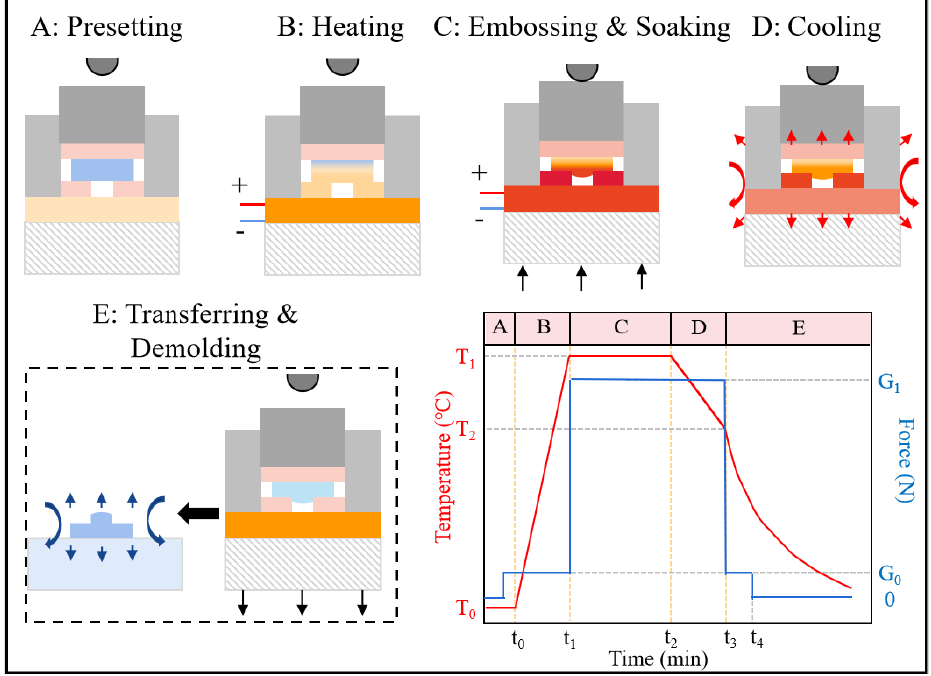
Figure 4. Schematics of the novel rapid hot embossing process.